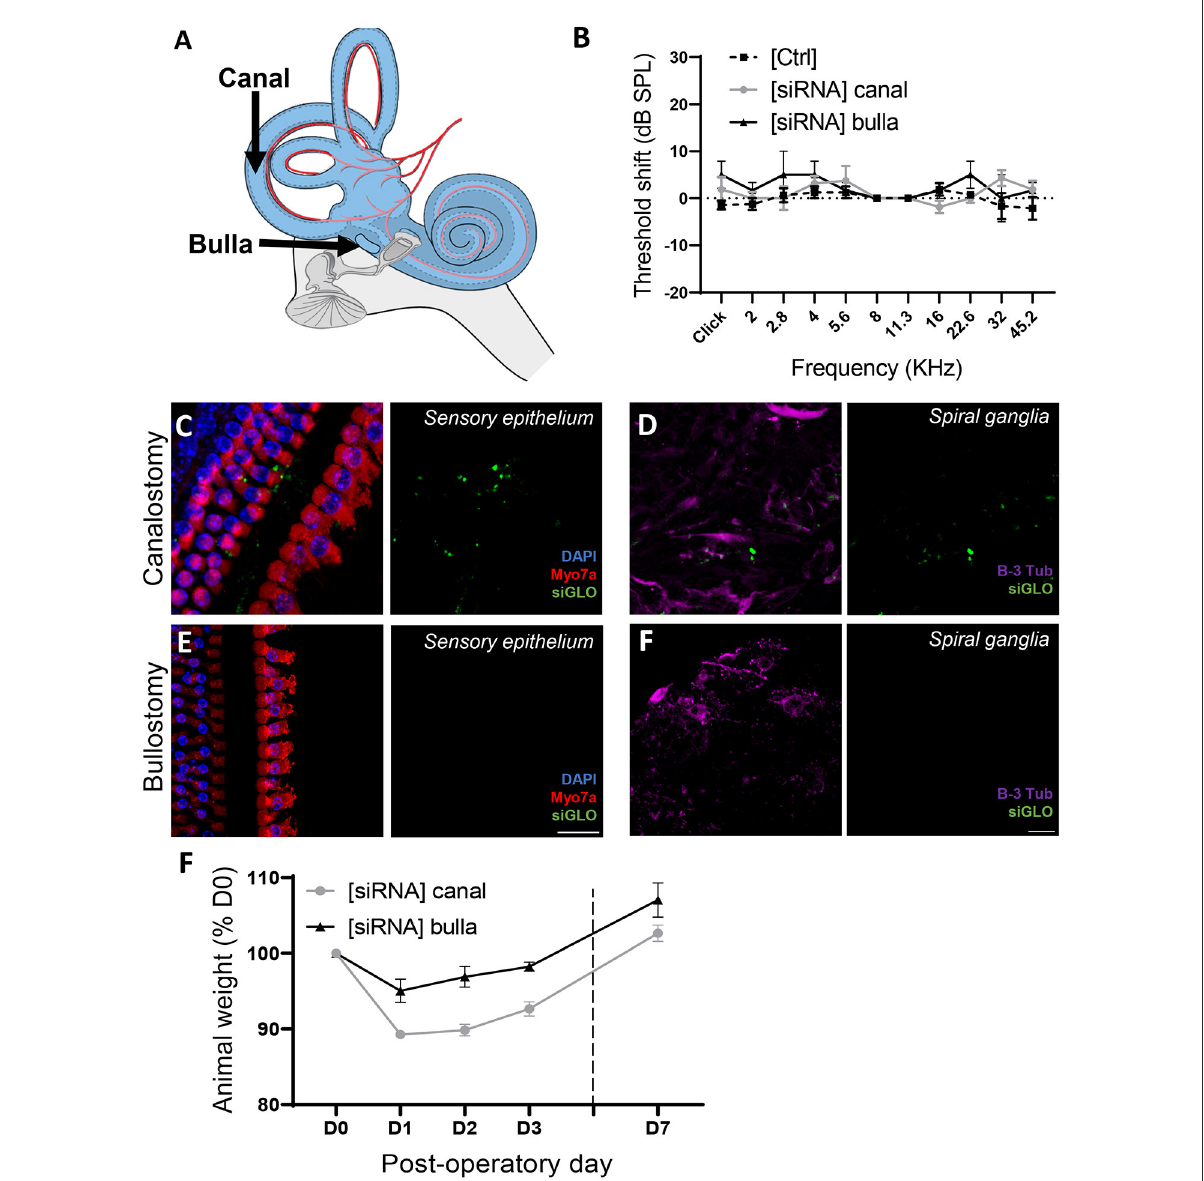
FIGURE6 Atraumatic siRNA delivery of siRNAs to the mouse inner ear. (A) 1 µ L of fluorescently conjugated siRNA (siGLO) was manually delivered into the middle ear, through the tympanic bulla (Bulla) or directly to the inner ear through the posterior semicircular canalostomy (Canal). (B) Auditory threshold shift measured by unilateral auditory brainstem response (ABR), recorded from contralateral [Ctrl] and operated [siRNA] ears ( n = 12) 3 days after surgery. (C,D) Cytocochleograms showing siGLO diffusion (green) to the sensory epithelium (inner and outer hair cells) (C) and spiral ganglia (auditory neurons ) (D) following canalostomy. (E,F) Cytocochleograms showing siGLO diffusion (green) to the sensory epithelium (inner and outer hair cells) (E) and spiral ganglia (auditory neurons) (F) following bullostomy. (C,E) Myo7a was used as hair cell marker (red), and DAPI (blue) was used for nuclear staining. (D,F) B-III Tubulin was used as neuron marker (purple). (F) Postsurgical weight evolution of operated animals was monitored up to day